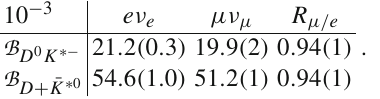
They agree with the experimental results tabulated in